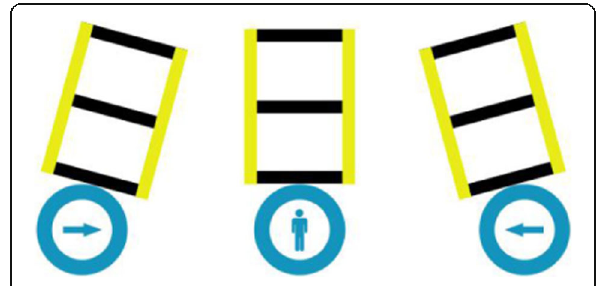
Fig. 1 The balancing principle of the balancing car